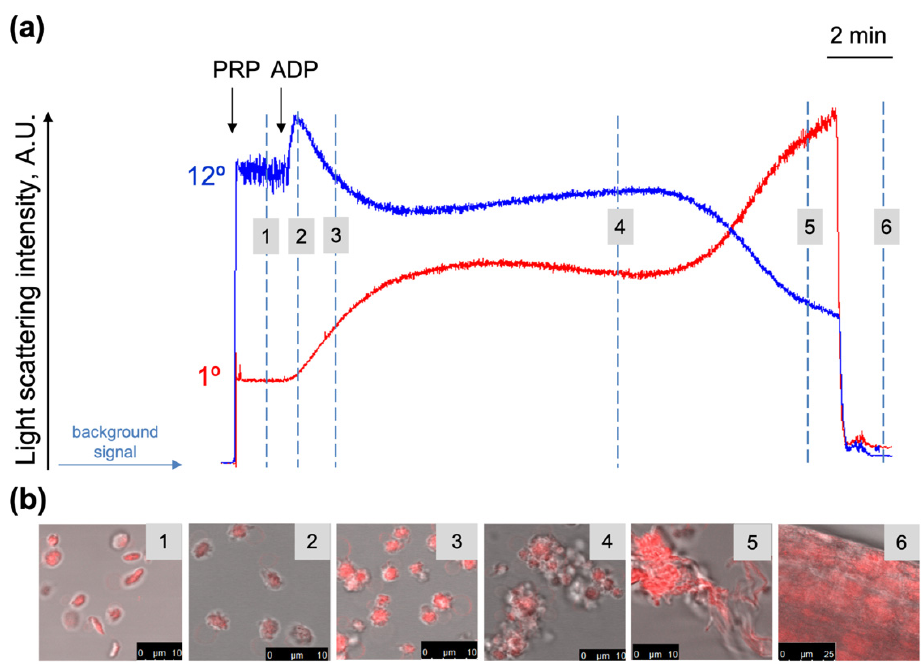
Figure 1. Registration of platelet transformations (shape change, aggregation, and clot formation) by laser diffraction method. ( a ) PRP diluted in the HEPES buffer (1 × 10 7 platelets/mL) was added to the cuvette with continuous stirring (1200 rpm) at 25 °C. After 2 min of incubation, ADP (800 nM) was added, and light scattering intensity (LSI) was monitored for the scattering angles of 1° and 12°. For better visualization, the LSI signal at 12° was amplified by 50; ( b ) at each step of platelet transformation, samples were withdrawn from the LaSca cuvette, fixed with formaldehyde (2%), and then stained with Nile Red (3 µg/mL, 10 min, RT) for confocal microscopy analysis of platelet aggregation and clot formation (Photos 1–6). Shown are the original representative traces and photos from four independent experiments.